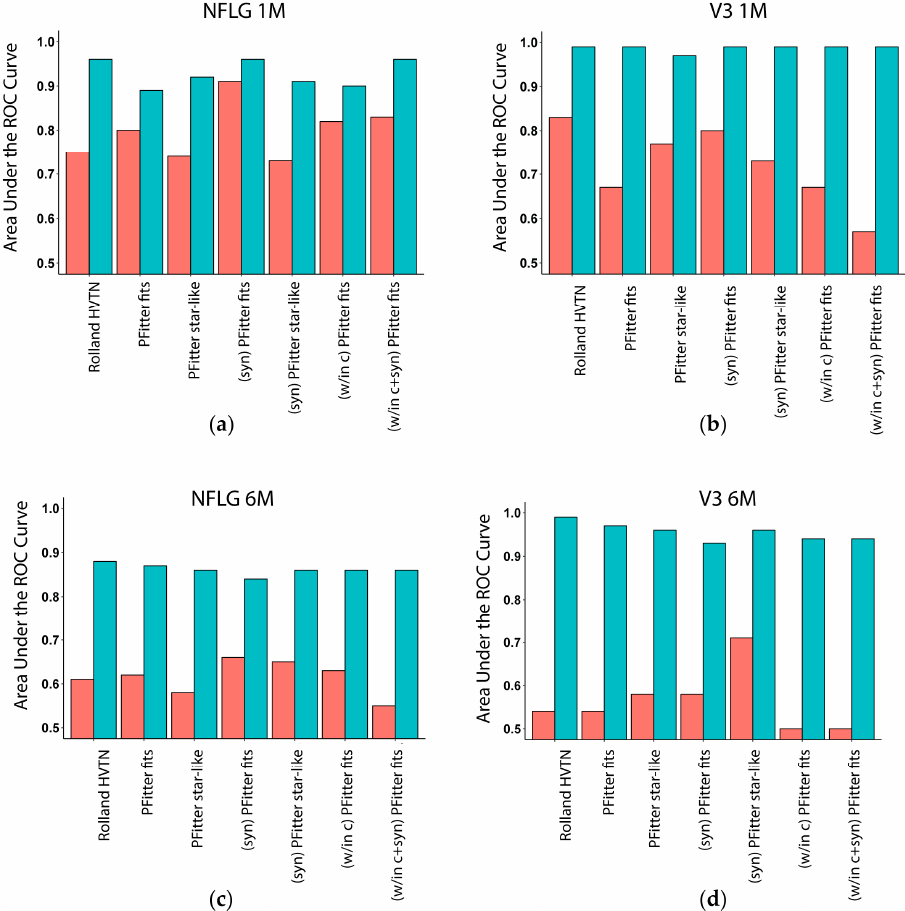
Figure 2. Multiplicity AUC of estimators of multiple-founder infections. Bar plots show areas under the receiver operating characteristic (ROC) curve (AUC) for uncalibrated (red) and calibrated (turquoise) predictors of multiplicity when evaluating predictions on held ‐ out values during leave one ‐ out cross ‐ validation, using the LASSO procedure to select and fit a logistic regression model. Uncalibrated predictors include the method used in the past HVTN sieve analyses, two values computed by the Poisson Fitter software to evaluate a fit to a star ‐ like phylogenetic model, and variants of these using preprocessed inputs (see Methods). Calibrated versions of these predictors are made using models trained using all available data, except for the one participant held out at a time (LOOCV). AUC values of 1.0 indicate a perfect predictor, and values of 0.5 indicate a predictor that is no better than random chance. The sequences used for prediction were: ( a ): RV217 NFLG 1–2 months; ( b ): CAPRISA 002 V3 1–2 months; ( c ): NFLG ~6 months; ( d ): V3 ~6 months.